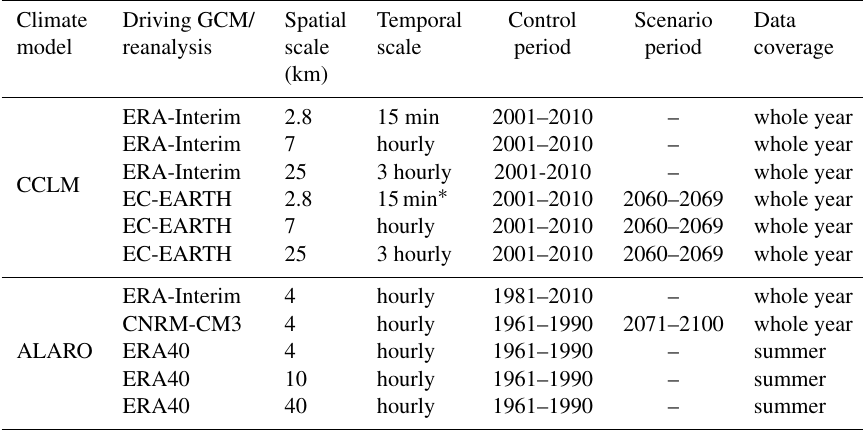
Table 1. The convection-permitting model runs used in this